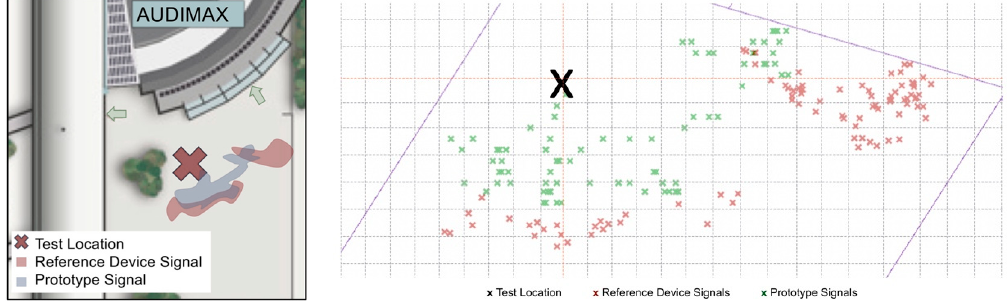
Figure 19. Georeferencing accuracy visualized over campus map; GPS location mapped with Grasshopper3D.